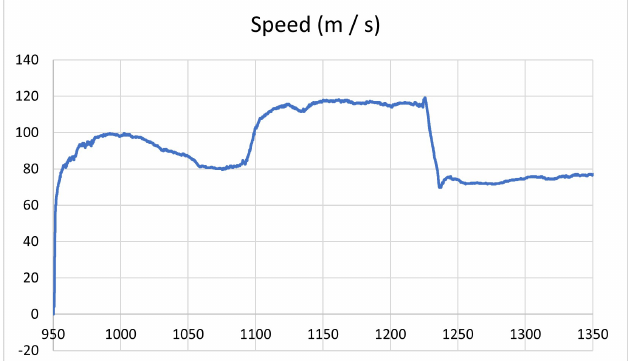
Figure 6. Speed: Validation Flight.